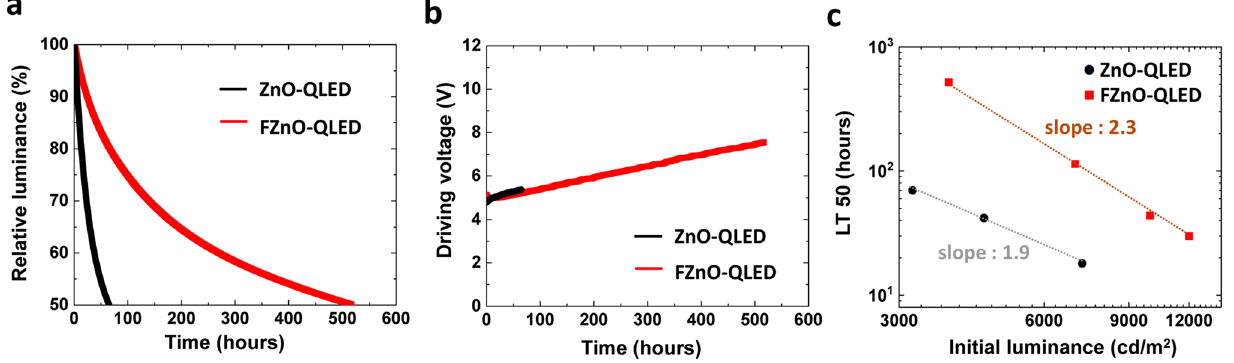
Fig. 3 a Luminance decay vs. time and b driving voltage vs. time of ZnO‑ and FZnO‑QLEDs with ZnO and FZnO ETLs operated at a constant current density of 20 mA cm −2 . c Measured LT50 values for different devices with operated at different L 0 values. The slopes correspond to the accelerator